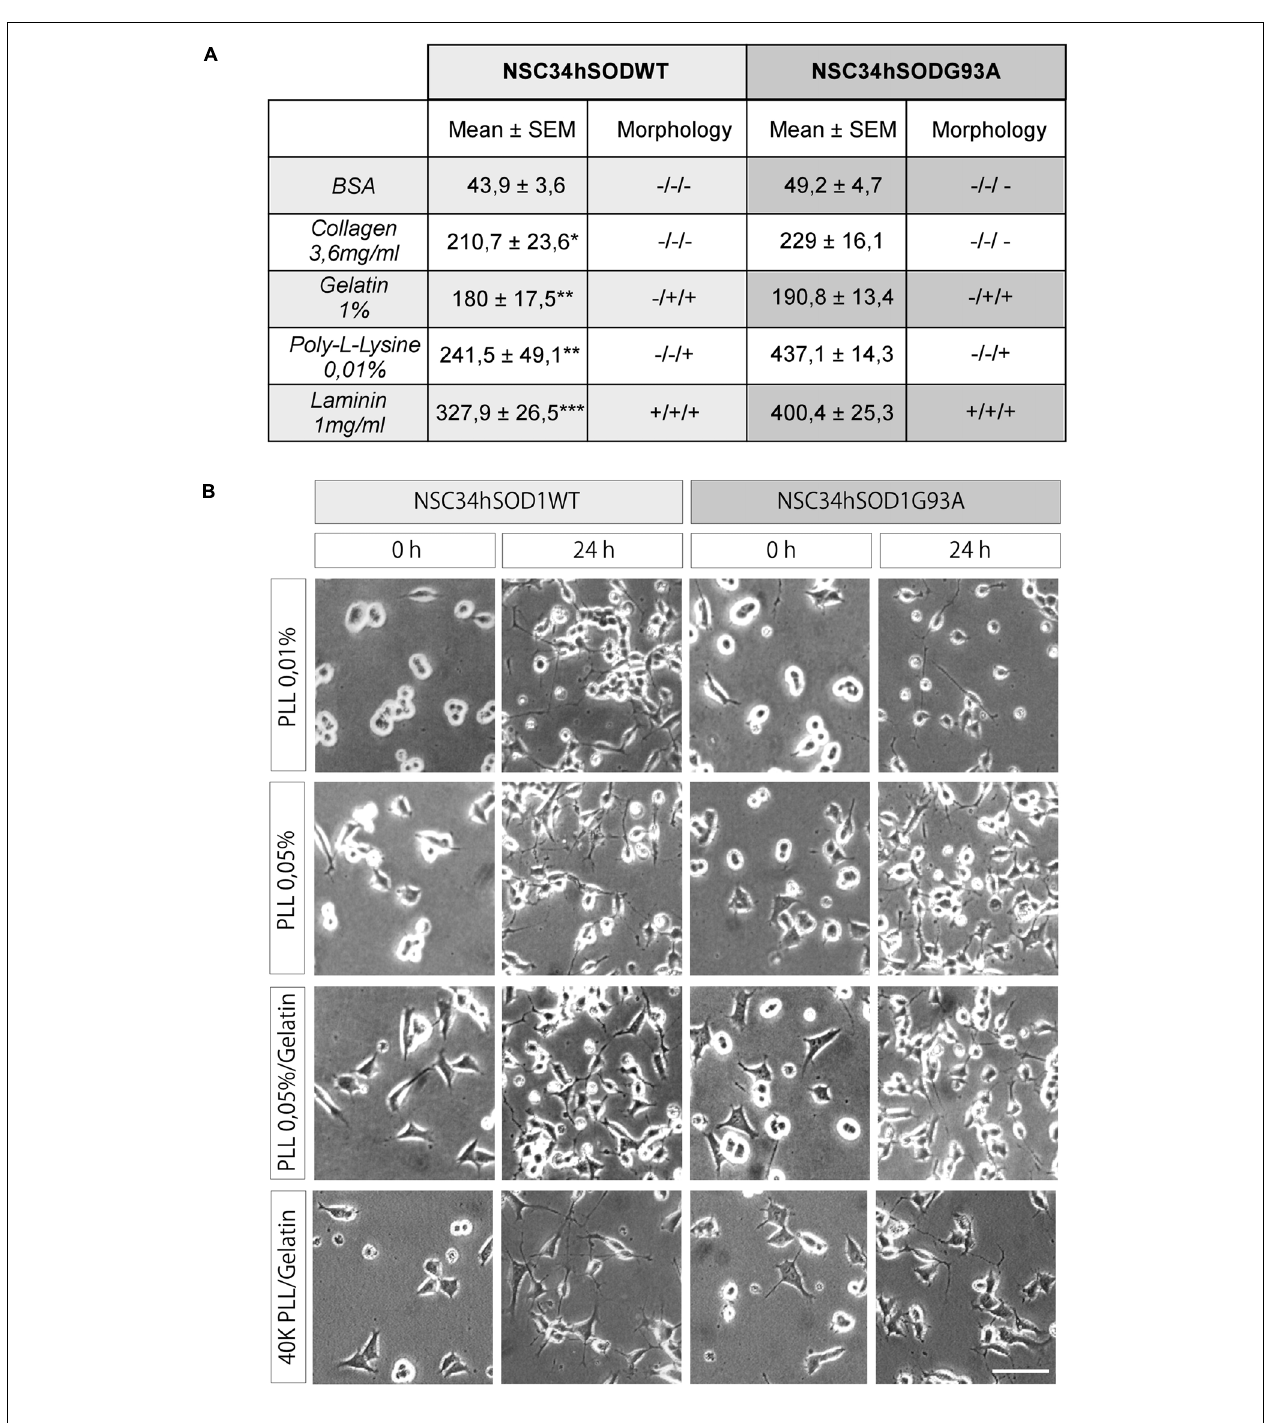
FIGURE 1 | PLL/gelatin coating is a good adhesion and differentiation substrate for NSC-hSOD1 cells. NSC34hSOD1 cells bind to different adhesion substrates. (A) Culture dishes were coated with methanol-solubilized nitrocellulose. Droplets containing collagen, gelatin, PLL, BSA, and laminin were applied to the surface of the dishes and dried. NSC34hSOD1 cells were then incubated for 2 h and examined by phase contrast microscopy. Table represents the average ± SEM of three independent experiments ( ∗ p < 0.05,